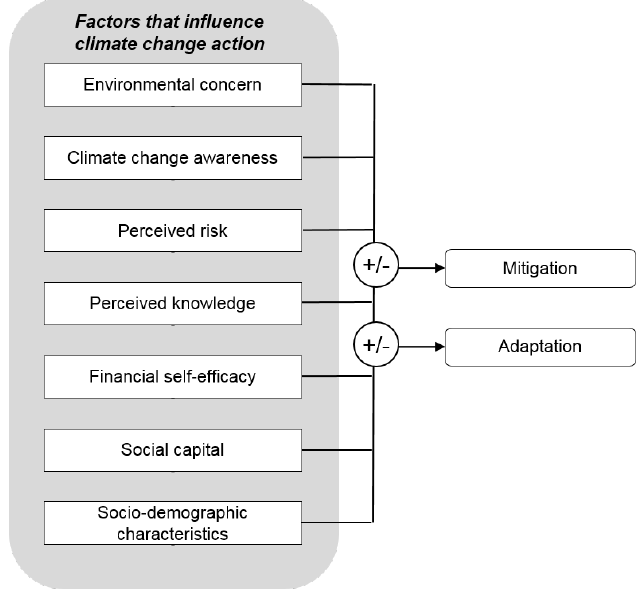
Figure 1. Factors that influence household-level mitigation and adaptation to climate change.